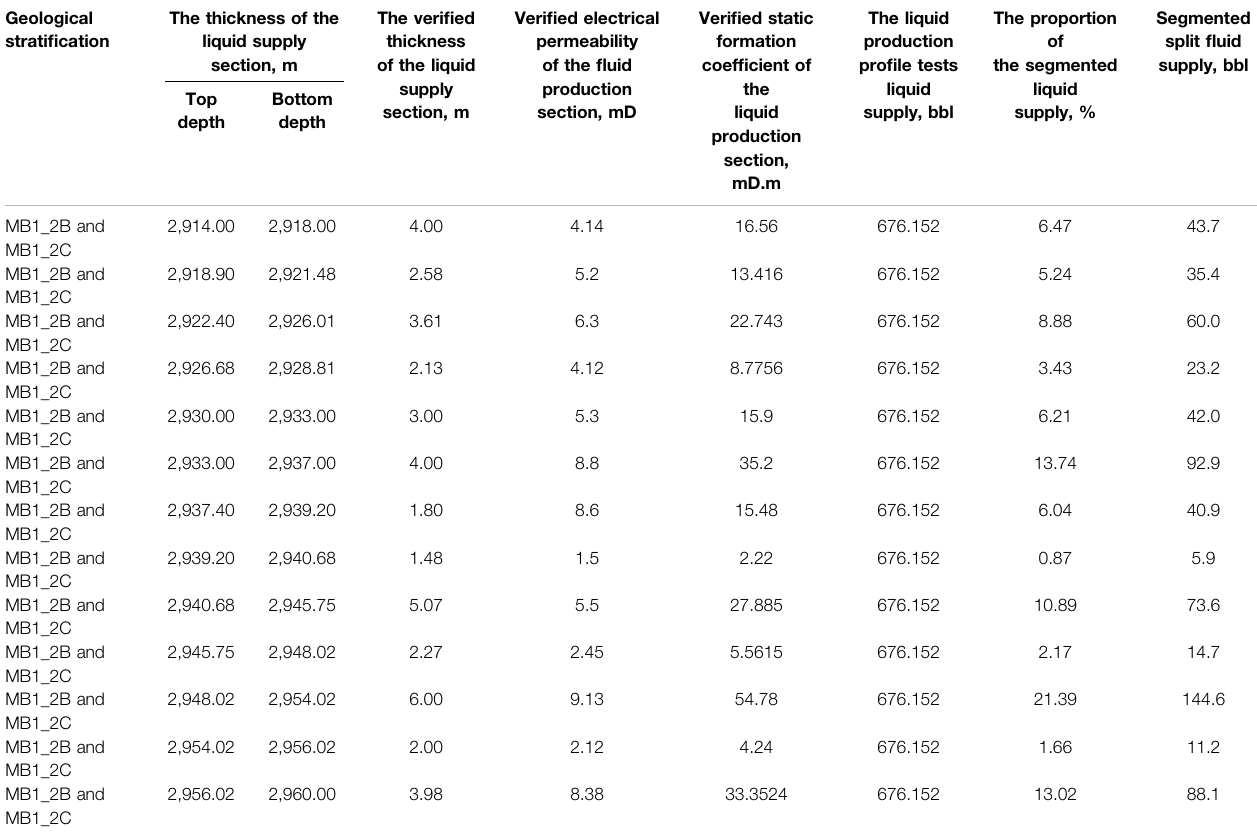
TABLE 3 | Summary of secondary splitting test results of MB1-2 of production pro fi le of P1. Geological strati fi